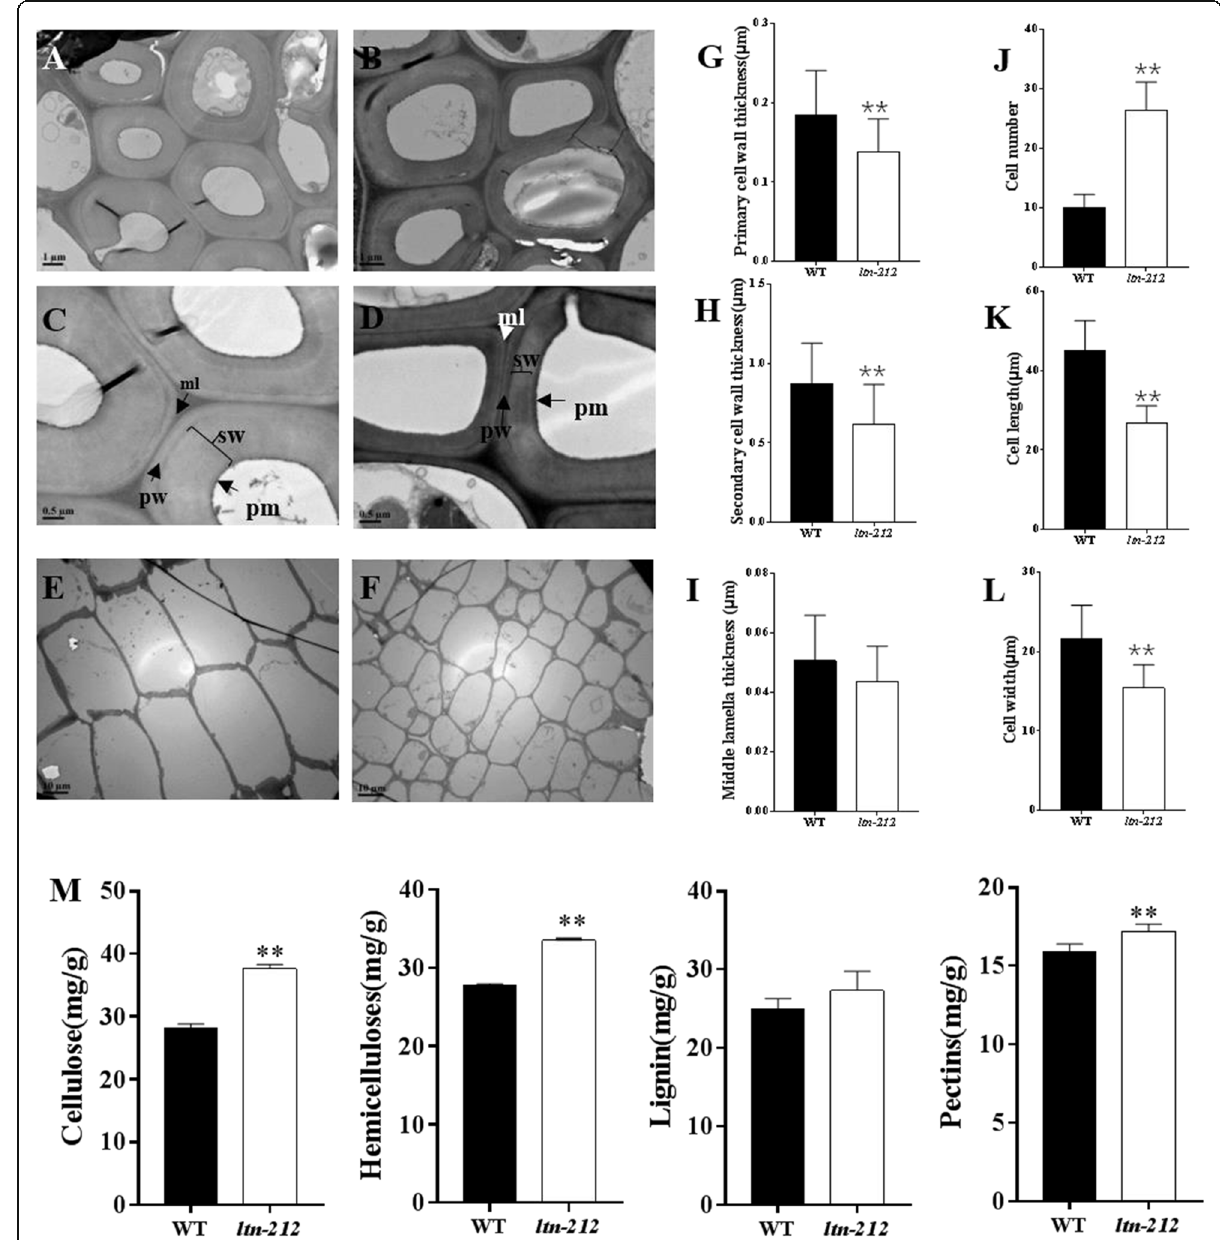
Fig. 6 Cell wall structure in WT and ltn-212 . a-b TEM micrographs of the bundle sheath fiber cells in leaves of WT ( a ) and ltn-212 ( b ) (scale bar = 1 μ m). c Magnification in ( a ), and D. magnification in ( b ) (scale bar = 0.5 μ m). E-F. TEM micrographs of the internode cell of WT ( e ) and ltn-212 ( f ) (scale bar = 10 μ m). g-i Statistical analysis of the primary cell wall, secondary cell wall, and middle lamella thicknesses of bundle sheath fiber cells in leaves of WT and ltn-212 . Data are means ± SD of 20 cells. j-l Statistical analysis of the cell number, cell length and cell width of WT and ltn- 212 . Data are means ±SD of 30 cells. m The cell wall composition of WT and ltn-212 ( n = 5). ** indicates significance at P ≤ 0.01 and * indicates significance at P ≤ 0.05 (Student ’ s t test). ml: middle lamella, pw: primary cell wall, sw: secondary cell wall, pm: plasma